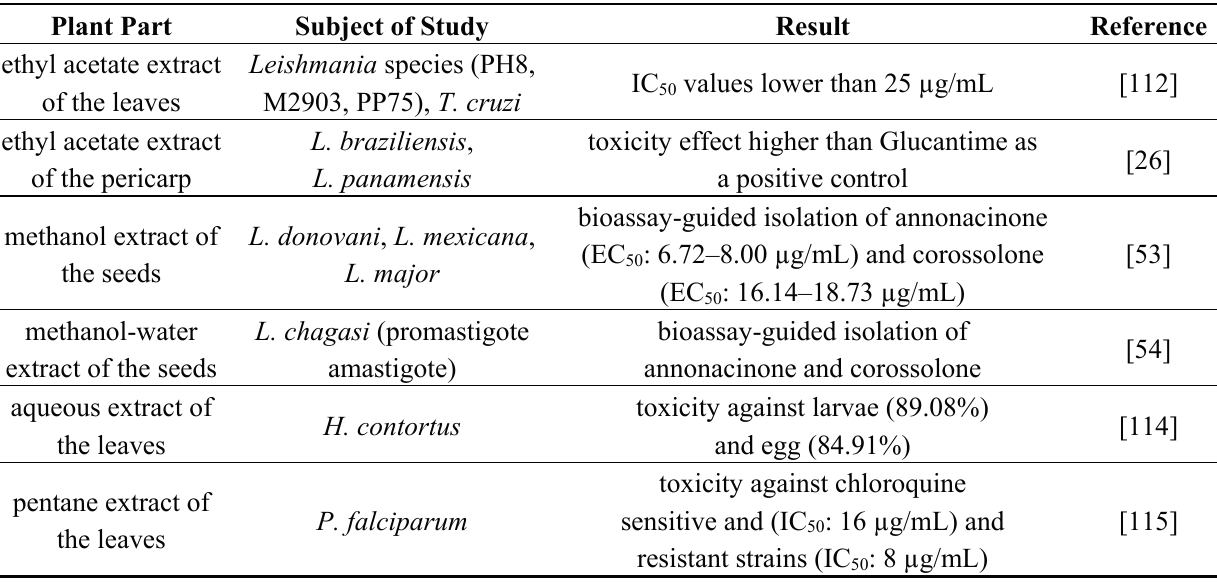
Table 3. Antiparasitic studies on A. muricata